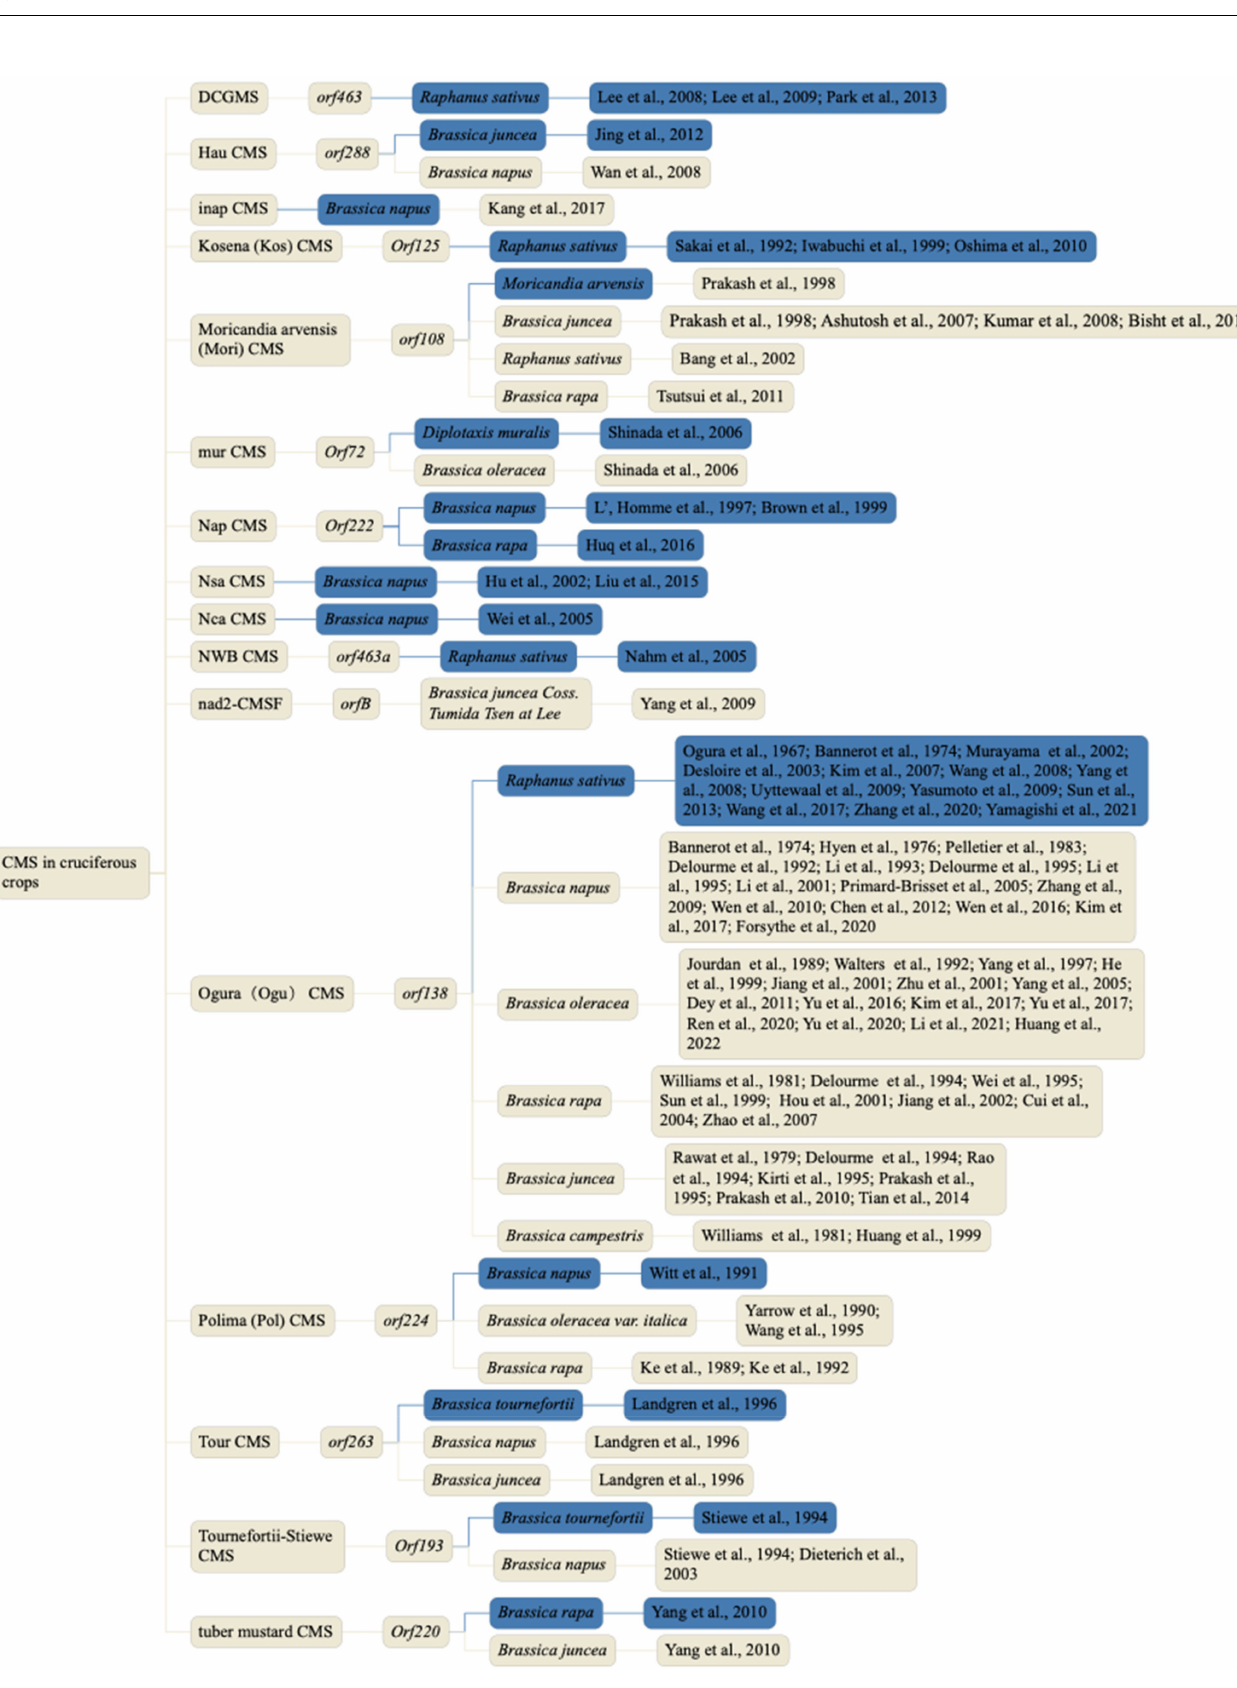
Figure 1. CMS systems reported in cruciferous crops. Blue indicates the origin of a cruciferous vegetable crop